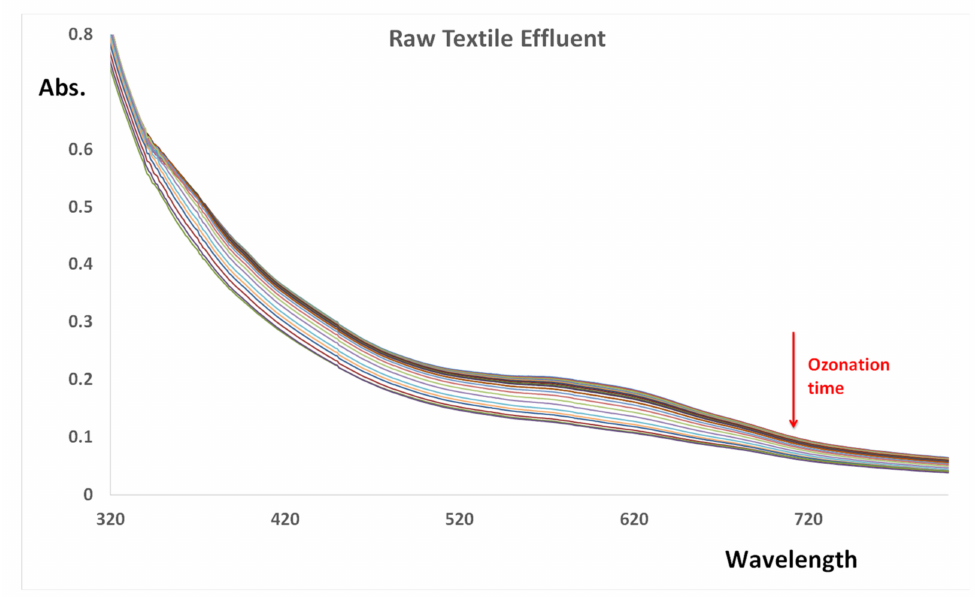
Figure 9. UV-Vis spectra of a real textile dying and printing industry as a function of ozonation